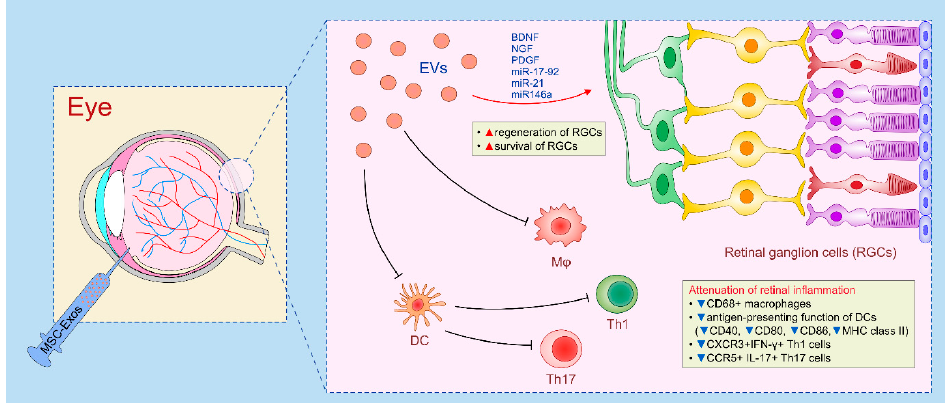
Figure 5. Molecular mechanisms responsible for beneficial effects of MSC-derived secretome in retinal